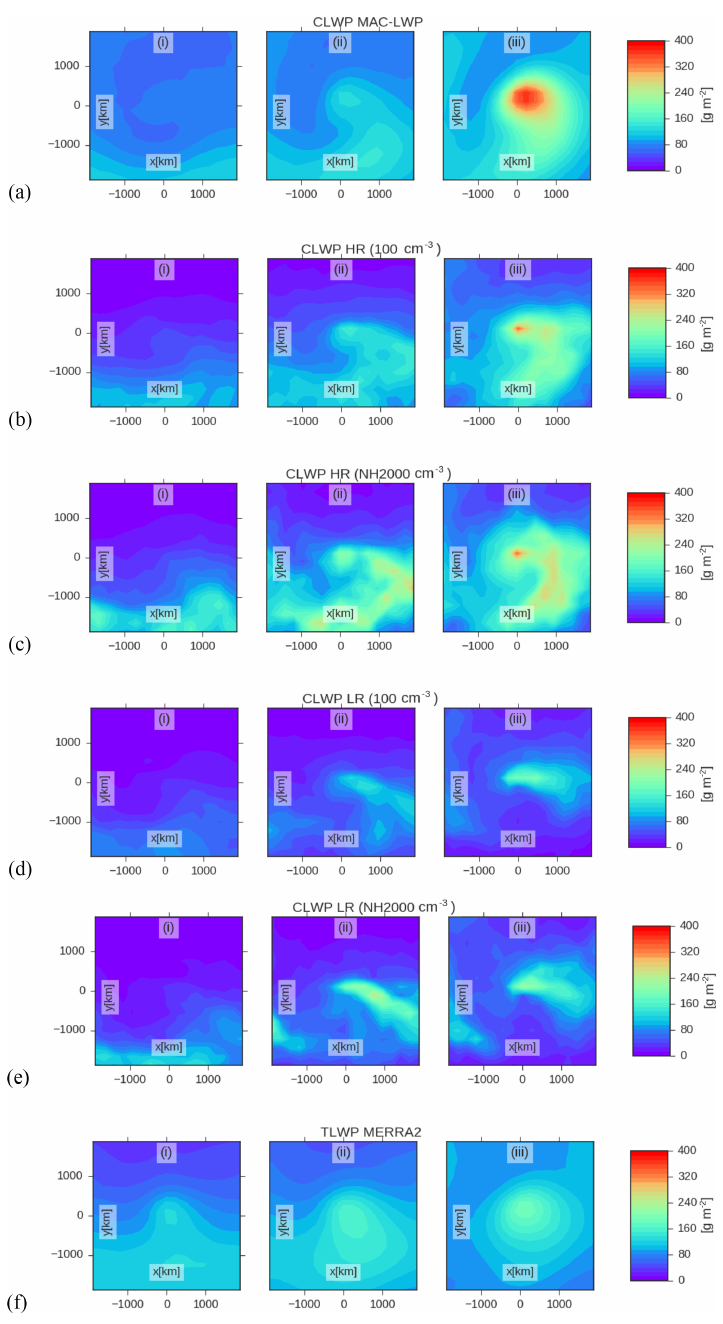
Figure 3. Cyclone composites showing CLWP from (a) MAC-LWP, (b–c) the convection-permitting simulation in the control and enhanced N acc experiments, (d–e) the GCM-surrogate simulation in the control and enhanced N acc experiments, and (f) MERRA2. All composites are shown in three bins of WCB moisture flux so that cyclones with similar meteorology can be compared. The bins are terciles of observed WCB moisture flux. Bins are shown in Fig. 5a and are noted in each subplot by (i)–(iii). It should be noted that the bin edges are not recalculated for the